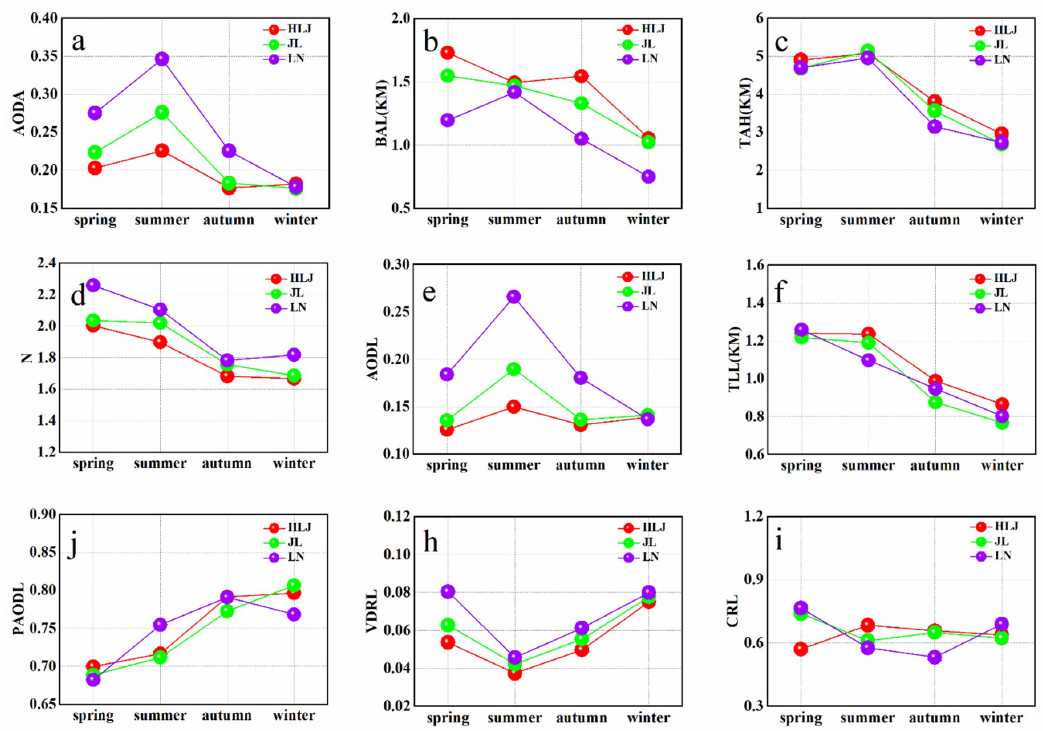
Figure 7. Seasonal variations in the optical and physical properties of aerosol layers over NEC (HLJ, JL, and LN) in the nighttime, from 2007 to 2014. ( a ) AODA, ( b ) BAL, ( c ) TAH, ( d ) N, ( e ) AODL, ( f ) TLL, ( g ) PAODL, ( h ) VDRL, and ( i ) CRL.